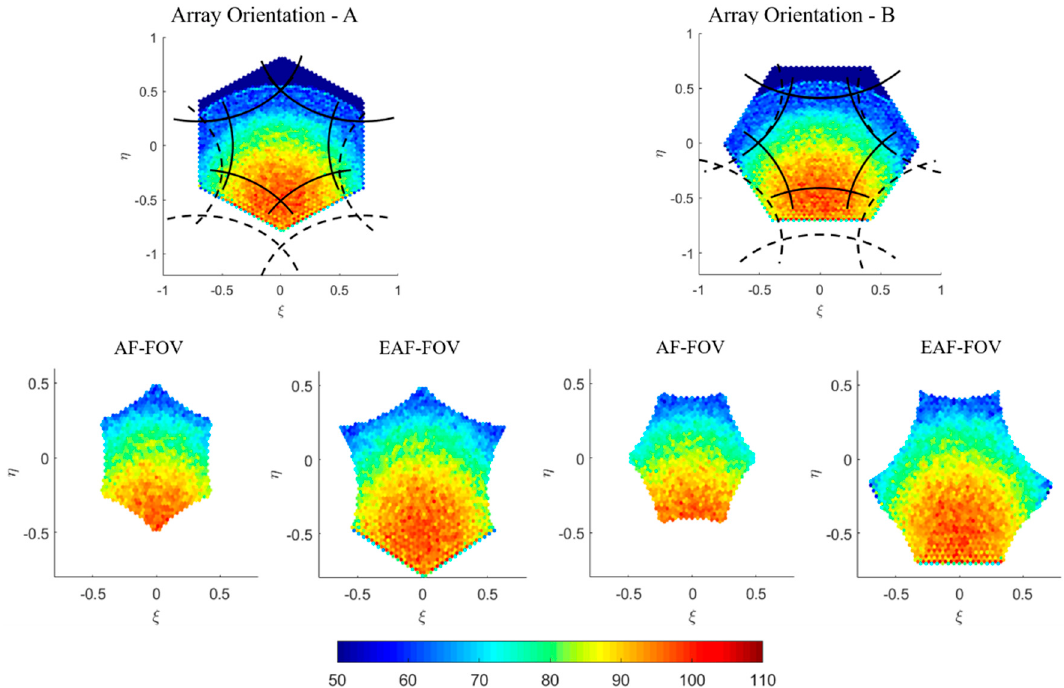
Figure 4. Illustration of the hexagonal-shaped brightness temperature (TB) image in horizontal polarization observed by the IMR in the antenna coordinate, according to different array orientations. The whole field of view (FOV) images are shown in the top, where the black solid lines represent for the six replicas (aliases) of the unit circle and the black dashed lines represent for the periodic repetition of the earth’s disk. TB images in the alias-free FOV (AF-FOV) and extended alias-free FOV (EAF-FOV) areas extracted from the whole FOV are displayed in the bottom. The axes are the director cosines ( 𝜉 − 𝜂 ) and the color bar represents TB values in Kelvin.